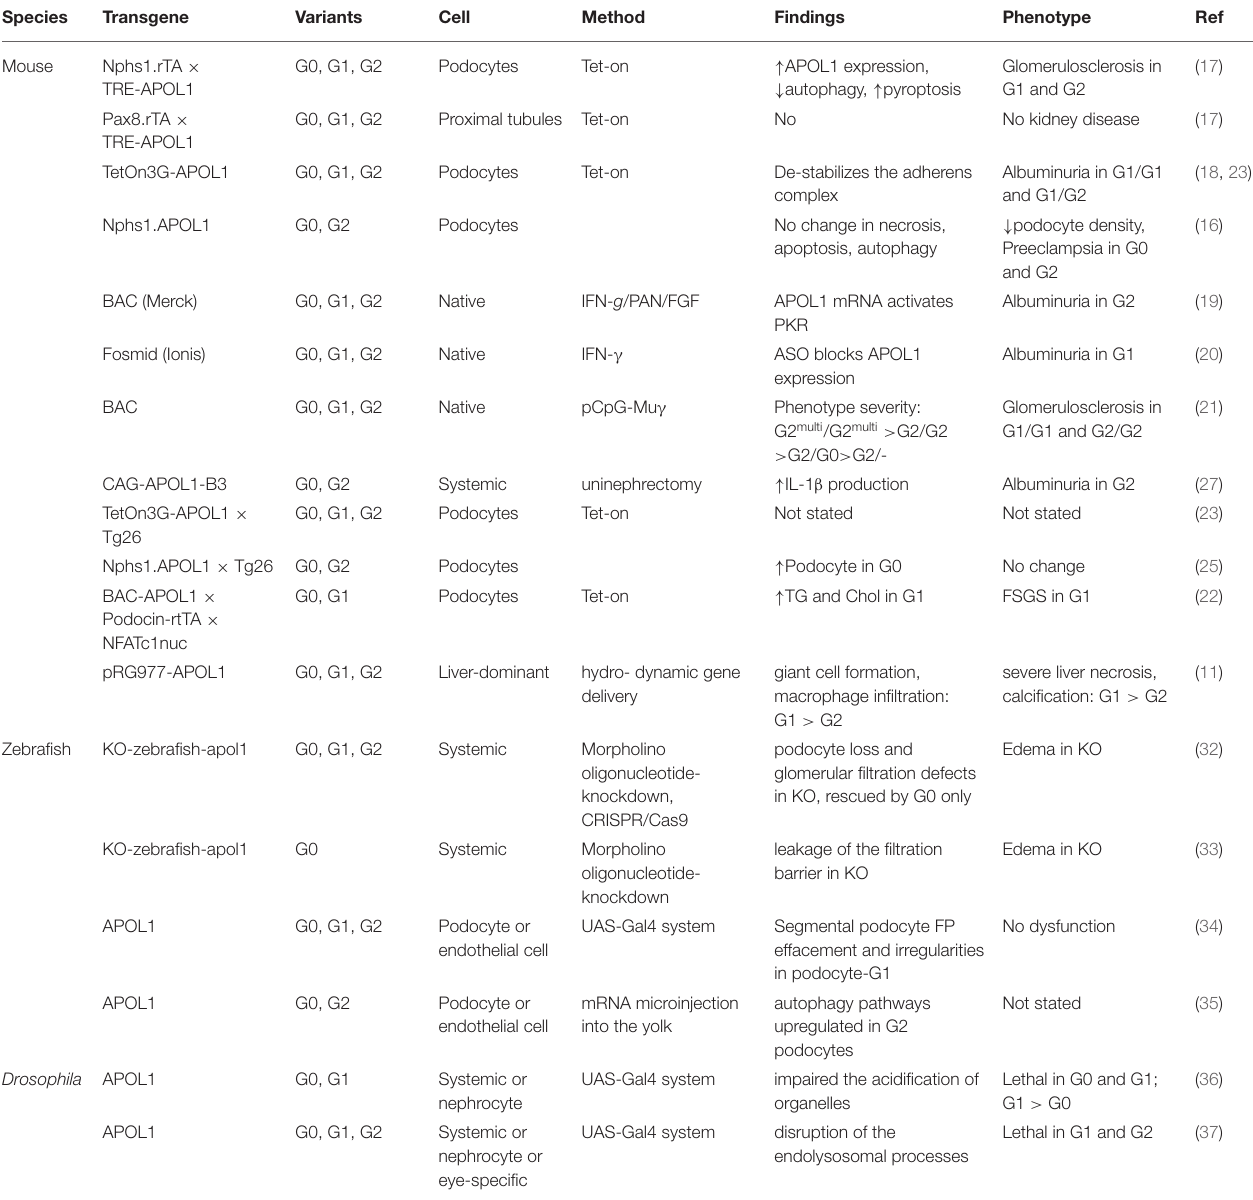
Shown are 18 transgenic models of APOL1 pathophysiology, involving three animal species. Methods used to generate models are shown. BAC,bacterialartificialchromosome;KO,knockout;CAG,cytomegalovirusimmediateearlyenhancer-chickenbeta-actinhybridpromoter;FGF,fibroblastgrowthfactor;PAN,puromycin aminonucleoside;rtTA,reversetetracyclinetransactivator;TRE,tet-responseelement;UAS-GAL4,upstreamactivationsequence,whichrespondswhenGAL4isexpressedandactivates the target gene; pCpG-Mu γ , an IFN- γ -expressing pCpGfree plasmid that lacks CpG